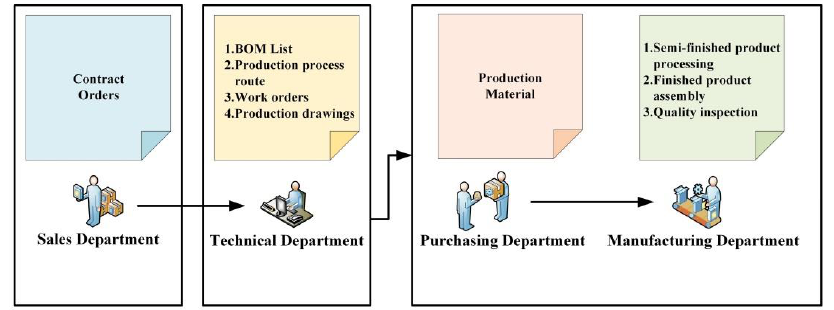
Figure 1. Production process of ETO manufacturing.